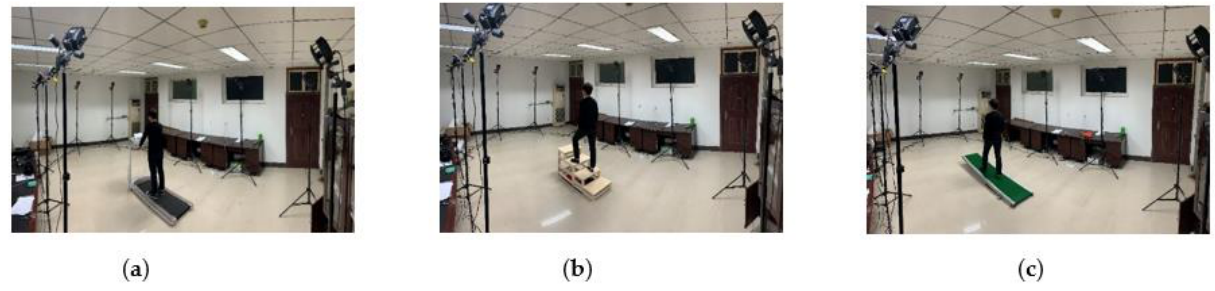
Figure 5. Experiment of motion information collection ( a ) Walking (𝑣 = 1m/s) ( b ) Up-stairs ( c ) Up-slope (5°) .